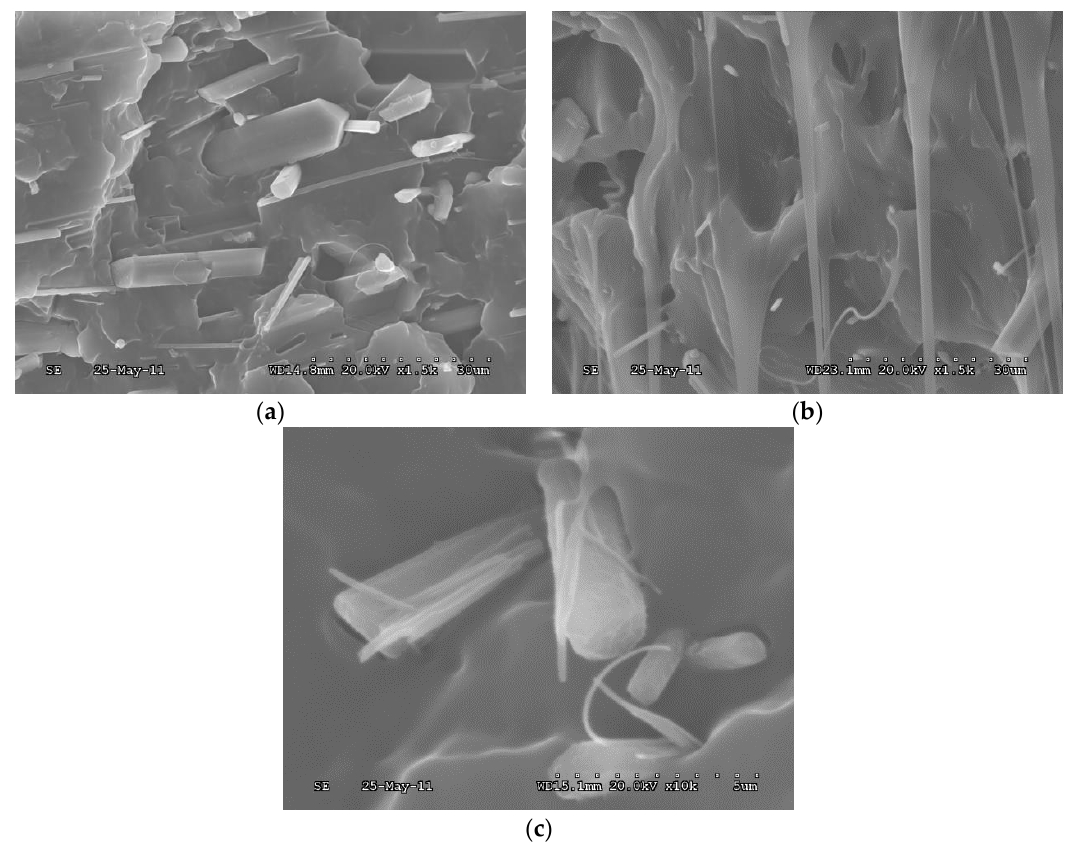
Figure 2. SEM images of the impact fracture surface of ( a ) PP/magnesium borate whisker (MBw), ( b ) PP/boric acid ester (BAE)-MBw (low magnification), and ( c ) PP/BAE-MBw (high magnification).